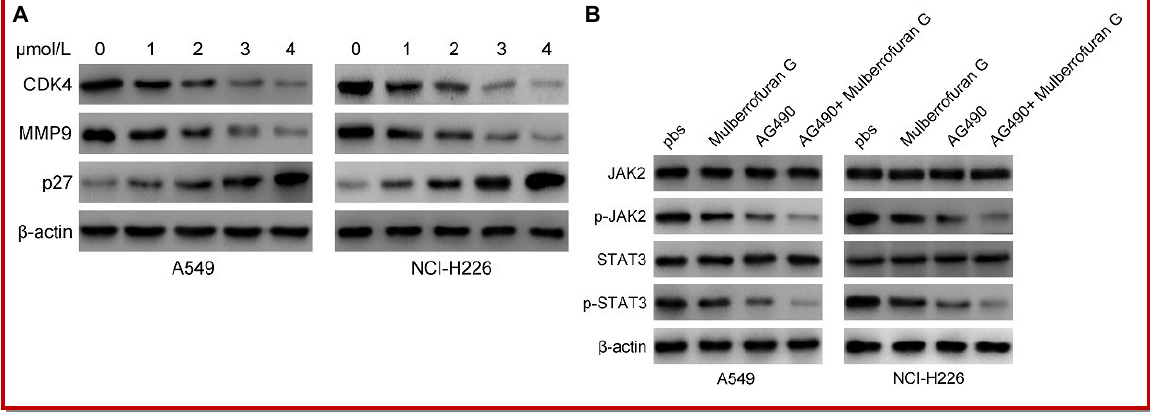
Figure 3: Effects of mulberrofuran G on related markers of the cell cycle (A) and metastasis (B) in A549 cells and NCI-H226 cells. β -actin was used as an internal control (A); Mulberrofuran G inactivated the JAK2/STAT3 signaling pathway in A549 cells and NCI -H226 cells. β -actin was used as an internal control